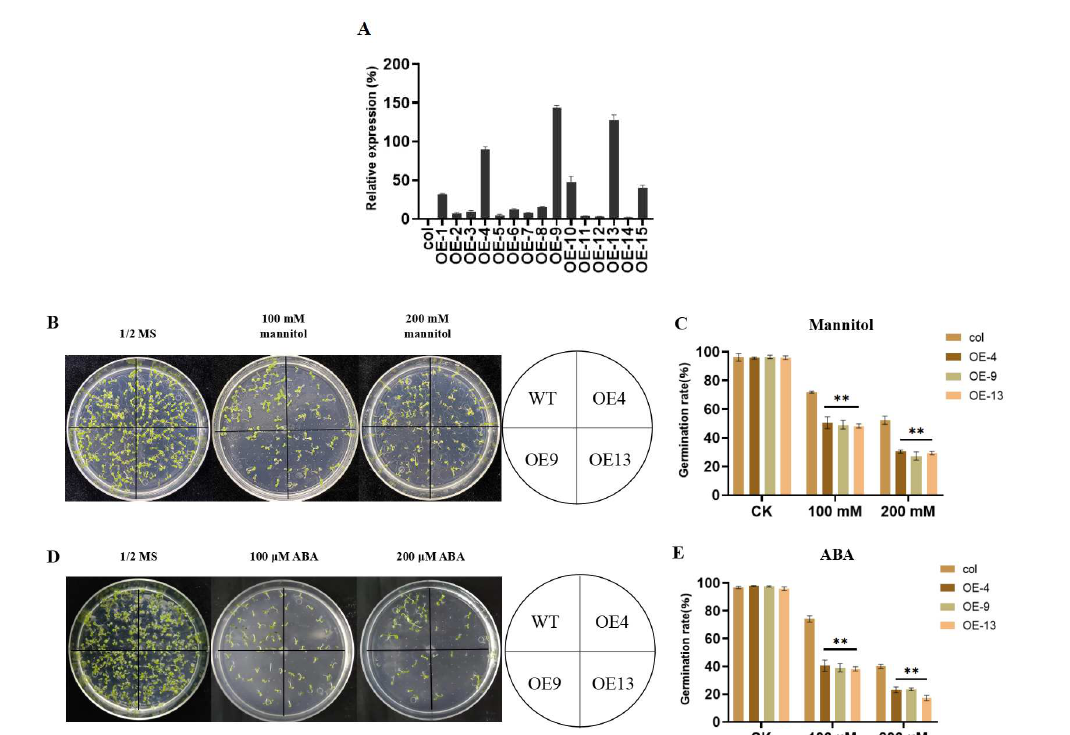
Figure 3. Drought resistance of wild-type and ZmGST26 -overexpressing Arabidopsis plants. ( A ) ZmGST26 expression in leaves of wild-type and overexpression lines Arabidopsis . ( B , C ) Seedling growth and germination rate in transgenic and wild-type Arabidopsis under mannitol treatment. ( D , E ) Seedling growth and germination rate in transgenic and wild-type Arabidopsis under ABA treatment. ** p < 0.01. All bars represent means ± SD, (n ≥ 3).